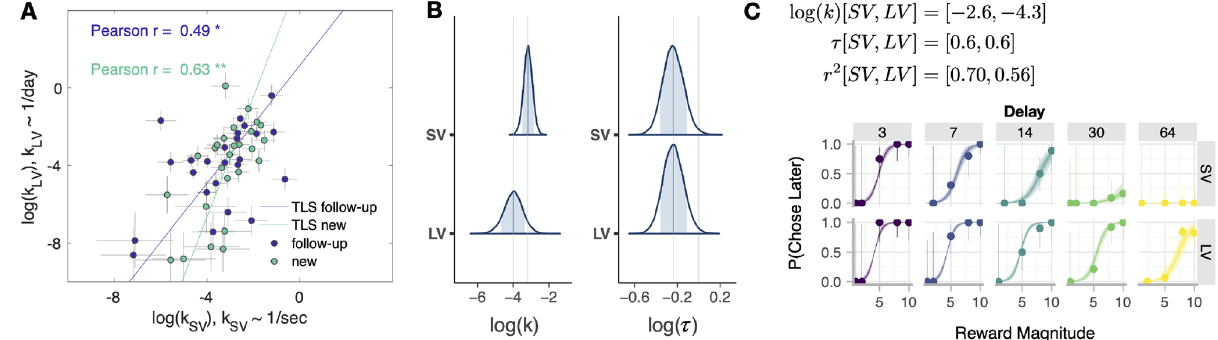
Figure 2. Comparison of discount factors across groups and tasks. ( A ) Each circle represents one subject ( N = 50 ). The log discount factors in short delay verbal task (SV, x-axis) plotted against the log discount factors in long delay verbal task (LV, y-axis). Discount factors were estimated in the units of the task. The color of the circles identifies the group, either follow-up (purple) or new (cyan). The error bars indicate the standard deviations of the log discount factor. The lines represent the total least squares (TLS) regression lines for two groups 27 . ( B ) Distribution of posterior parameter estimates of log ( k ) and log (τ) from the model fit of the new group of subjects. ( C ) Intertemporal choices and softmax-hyperbolic fit of one example subject from the new group. In each panel, the marker and error bar indicate the mean and binomial confidence intervals of the subject’s choices for that offer. The smooth ribbon indicates the BHM model estimates (at 50, 80, 99% credible intervals). Each column shows the choices for a specific delay (in seconds for SV, top row; in days for LV, bottom row). At the top of the subject plot we indicated the mean estimates of log ( k ) , τ and the Bayesian r 2 for each task for that